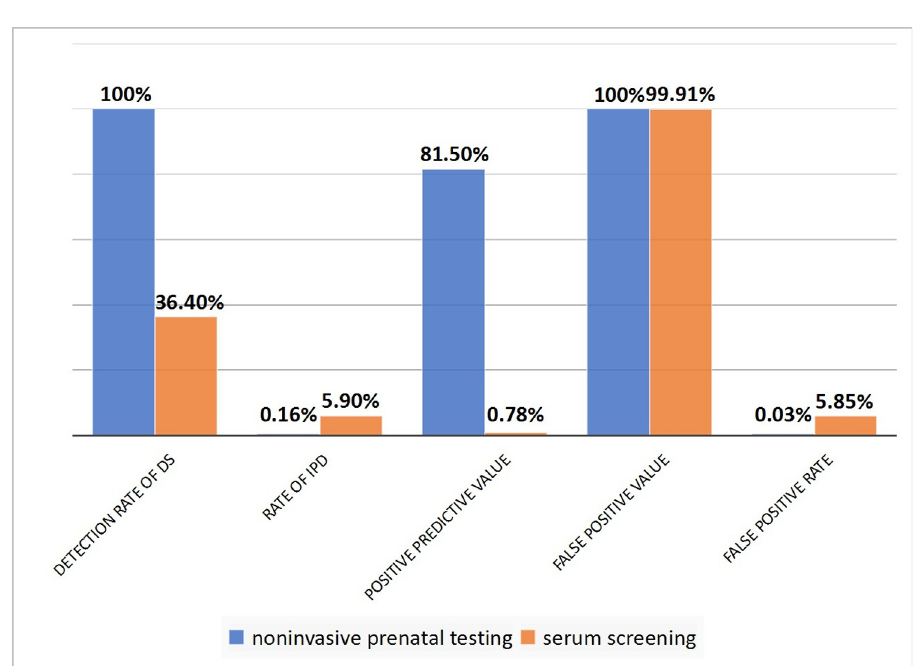
Fig 2. Comparison of various indicators in the statistical results of NIPT and SS.